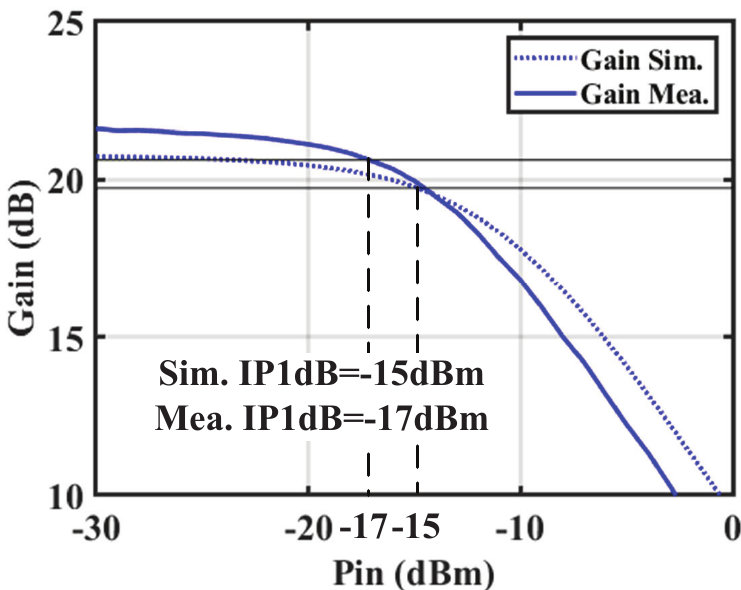
Figure 8. Simulated and measured IP1dB of the LNA at 30 GHz.